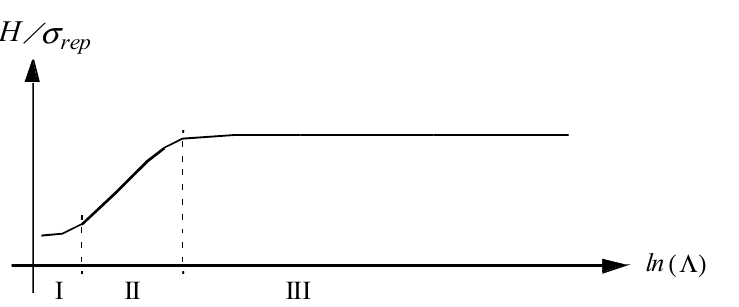
Figure 1. Sketch of the characteristic behaviour at indentation [4]. The indentation hardness H divided by the representative stress σ rep is plotted against the non-dimensional strain parameter Λ . The different levels at indentation are indicated.